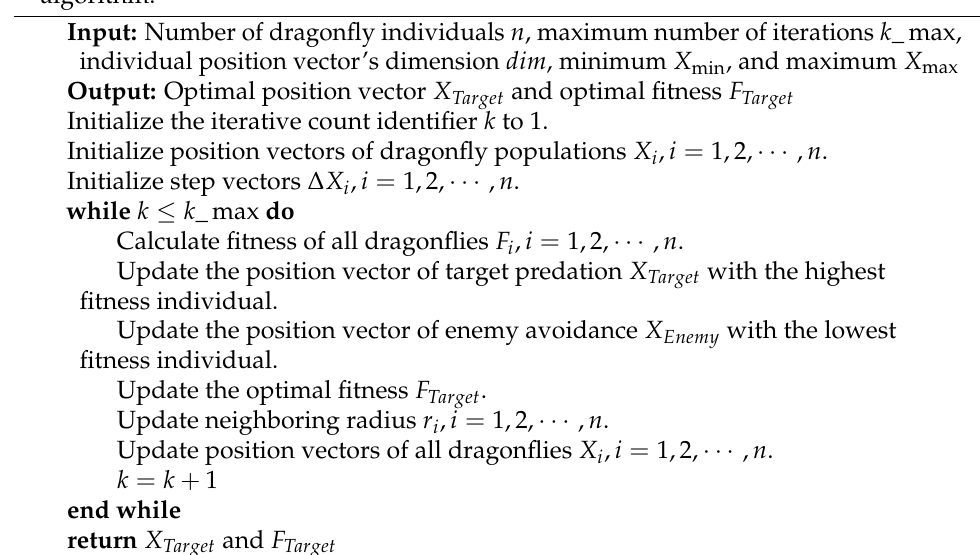
Algorithm 1: Optimization of A-ECMS equivalent factors based on dragonfly